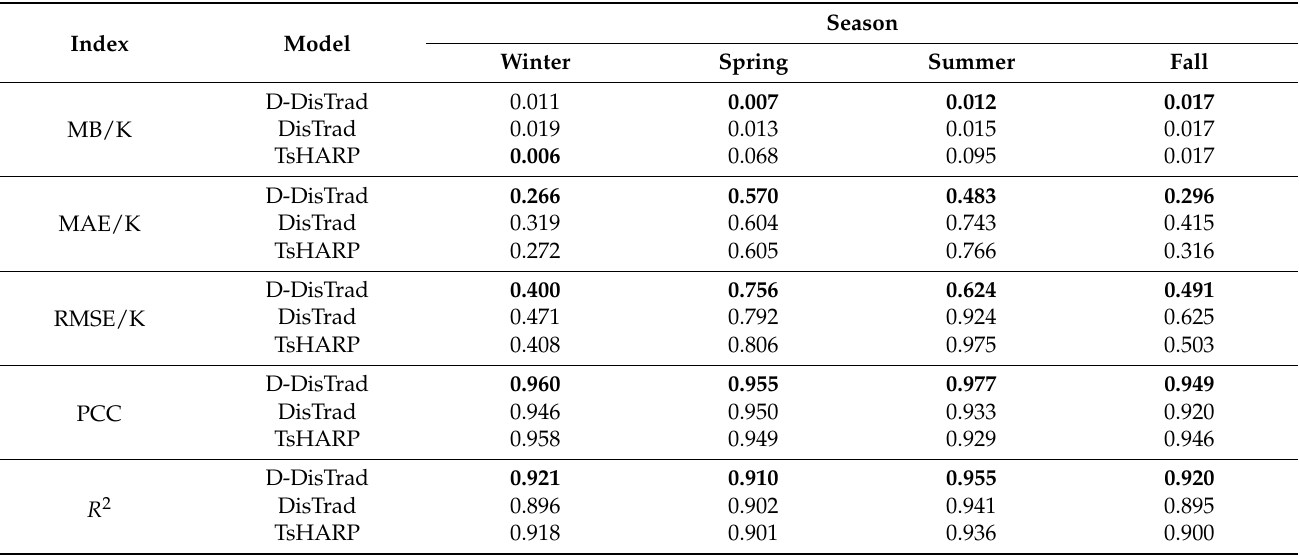
Table 6. Statistics for the three downscaling results aggregated to 900 m in comparison with the SLSTR LST data for 4 seasons at site 3.